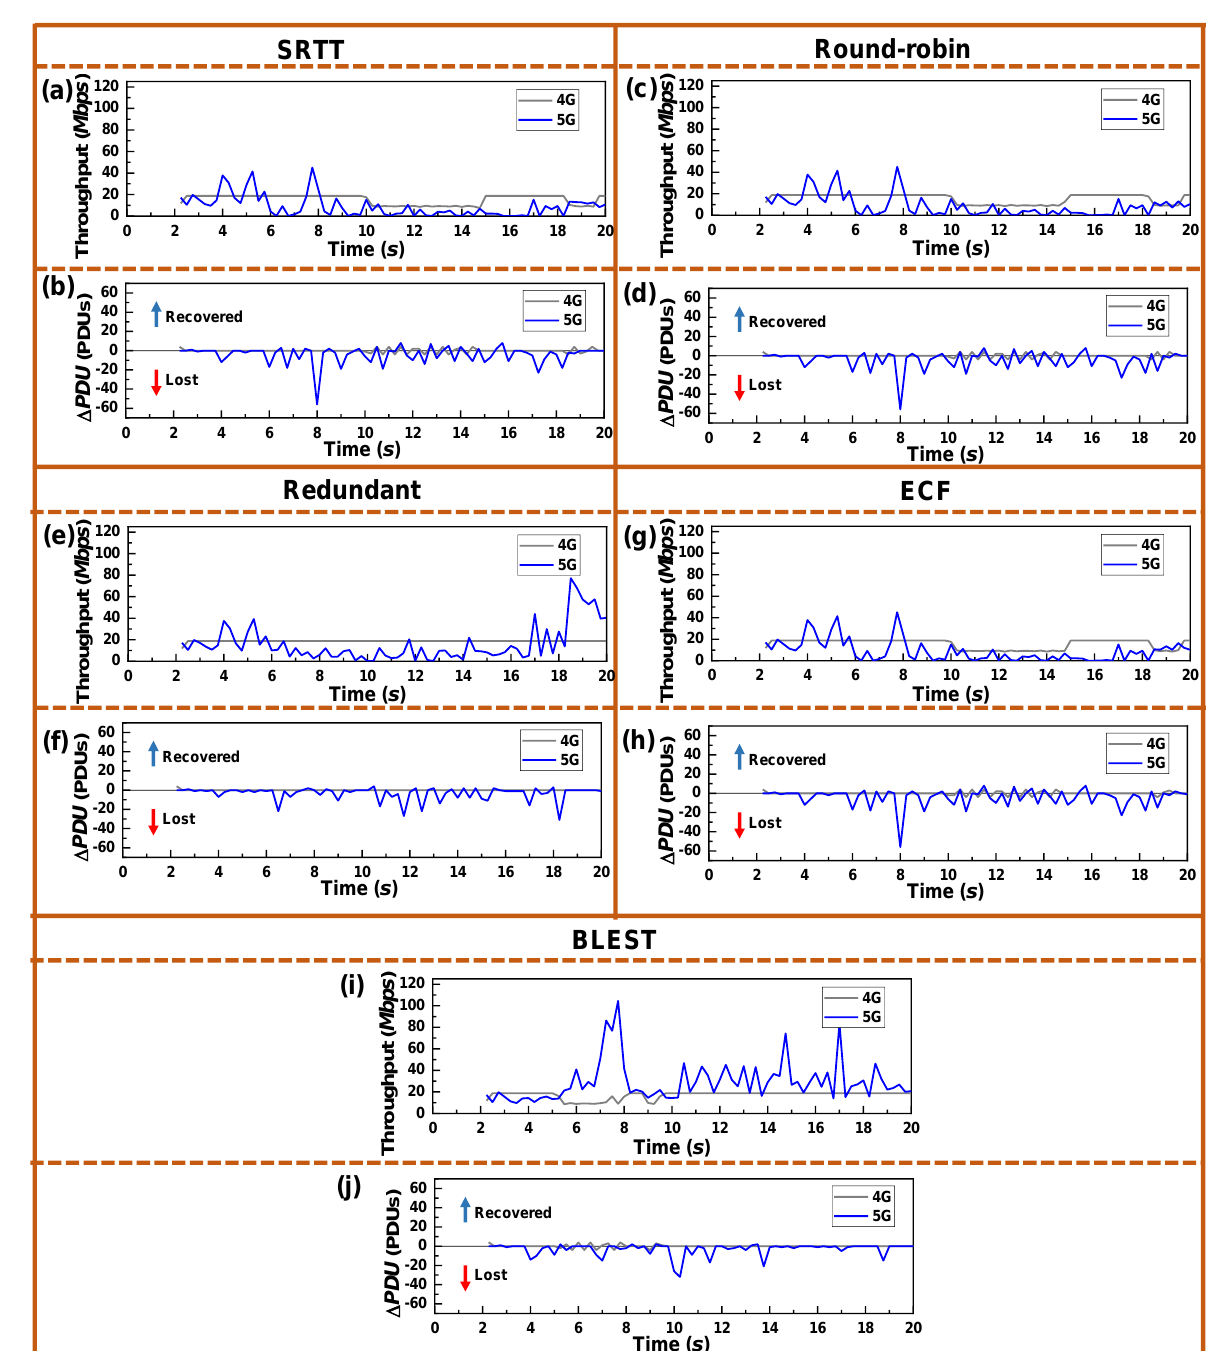
Figure 9. Real-time performance of the tested MPTCP schedulers for BALIA as a CCA in terms of throughput and Δ PDU for: ( a , b ) SRTT, ( c , d ) Round-robin, ( e , f ) Redundant, ( g , h ) ECF, and ( i , j ) BLEST, respectively.